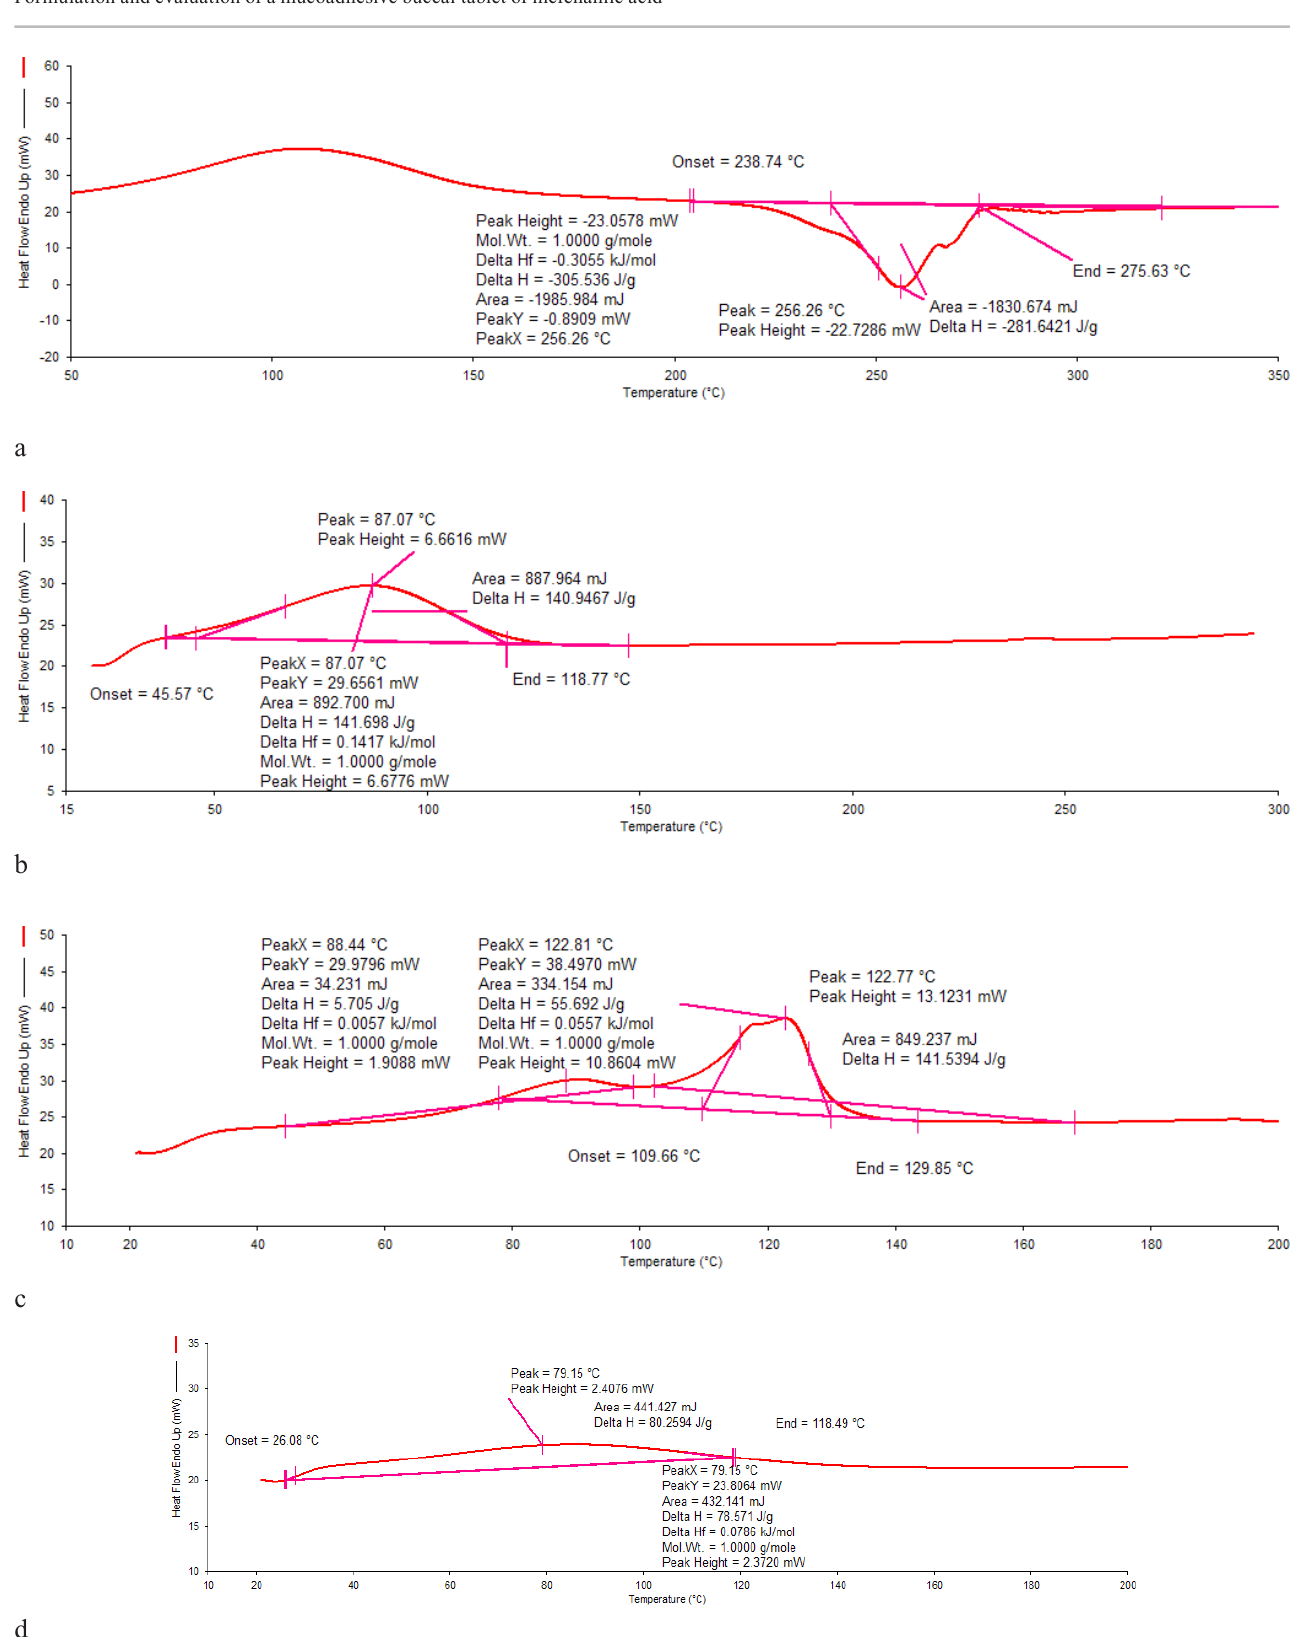
FIGURE 4 - a. DSC Result of a. Sodium Alginate; b. Hydroxypropylmethylcellulose K4M (HPMC K4M); c. Sodium Carboxymethylcellulose (SCMC); and d. Magnesium